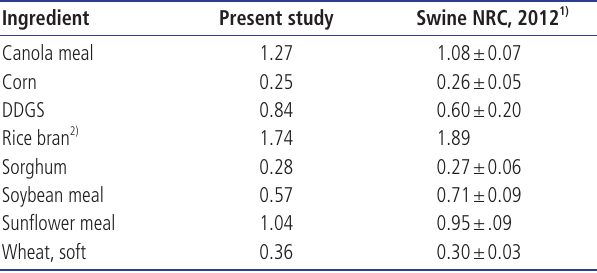
Table 4. Bayesian information criterion (BIC) for the regression models evaluated 1)